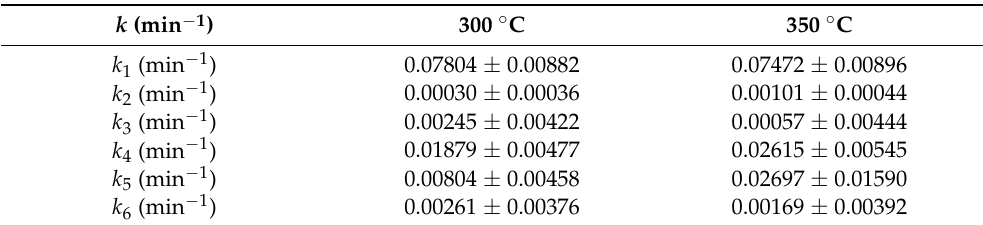
Table 3. Reaction rate constants for irreversible sequential reactions of PET waste in SubCW at different